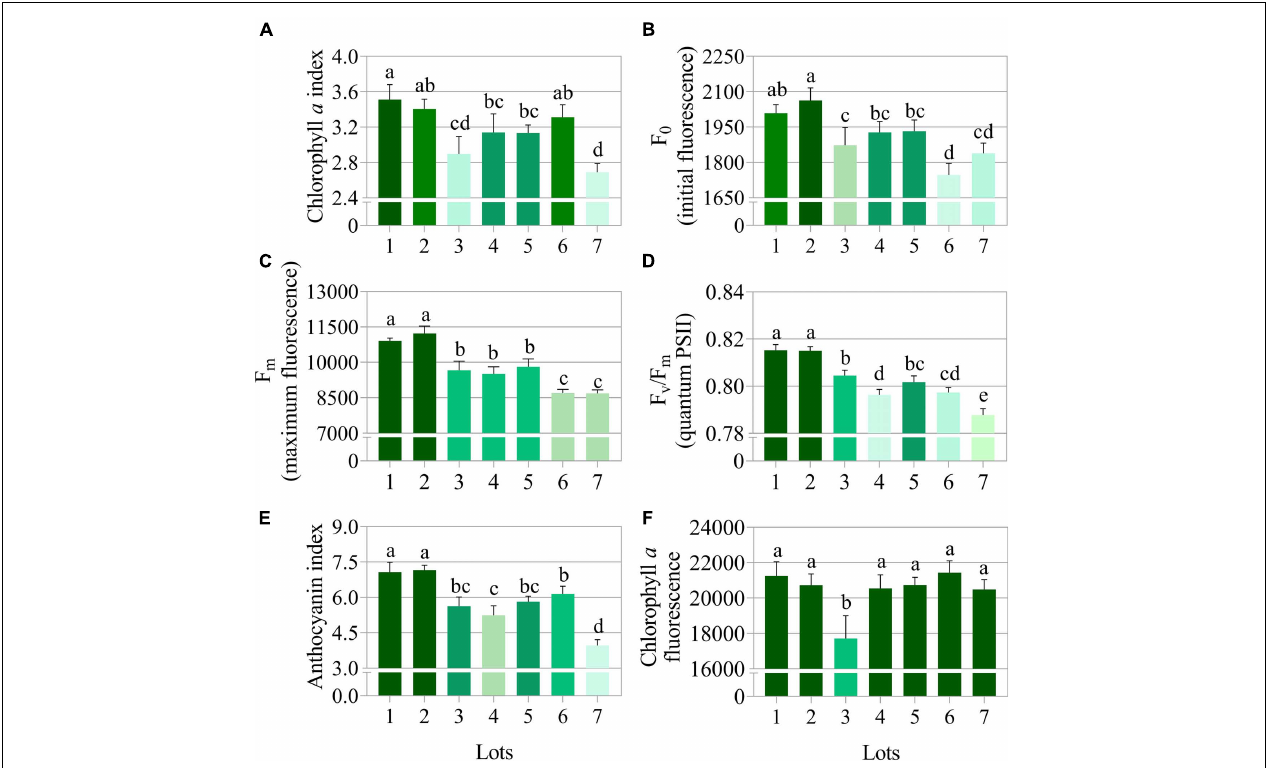
FIGURE 10 | Photosynthetic activity measured by chlorophyll a index (A) , initial fluorescence (F 0 ) (B) , maximum fluorescence (F m ) (C) , quantum yield of photosystem II measured by F v /F m (D) , anthocyanin index (E) , and chlorophyll a fluorescence (F) in peanut seedlings ( Arachis hypogaea L.; cv. IAC OL3) at 14 days after sowing: excitation of chlorophyll molecules were induced at 620 nm and emission at 700 nm. Means ( ± standard deviation) with different letters indicate a significant difference (p ≤ 0.05). Peanut seedlings were obtained from seeds of lower (Lots 1, 2, and 3) and higher vigor (Lots 4, 5, 6, and